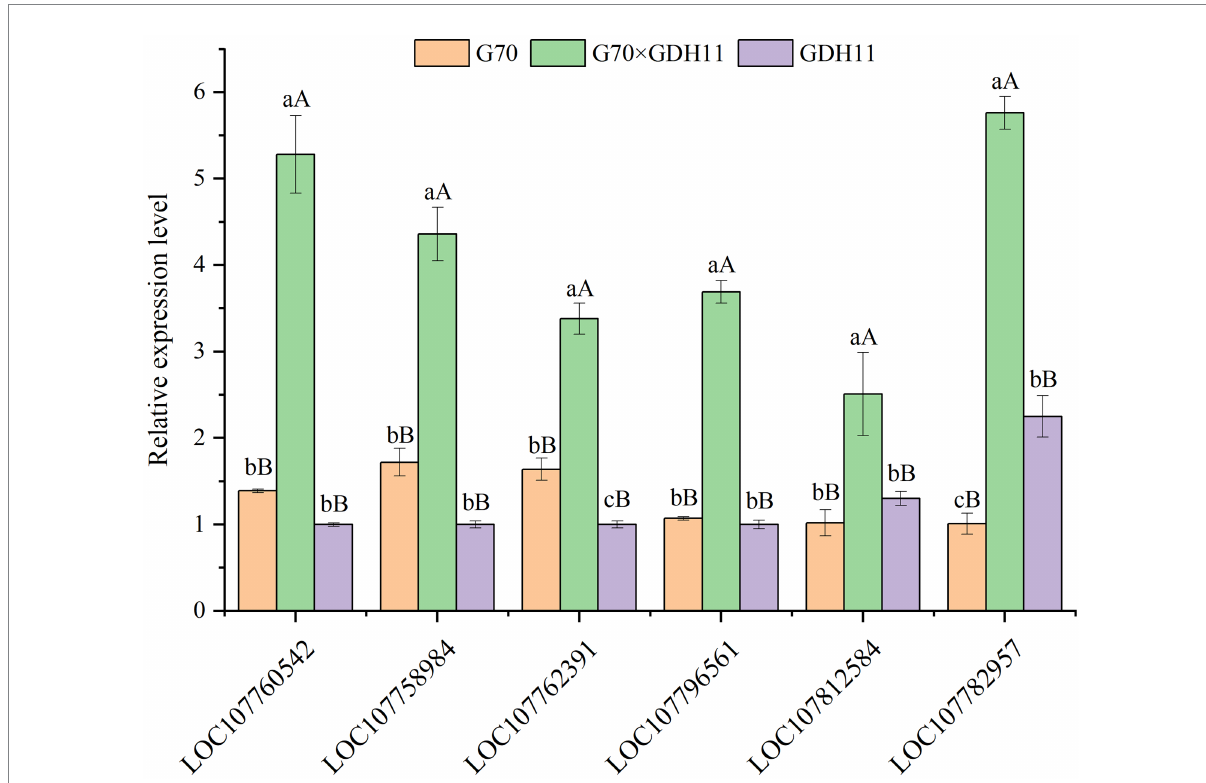
FIGURE 7 Expression level analysis of K + related genes by qRT-PCR. The lowercase alphabets represent a significant difference ( p < 0.05), while the uppercase alphabets represent a highly significant difference ( p <